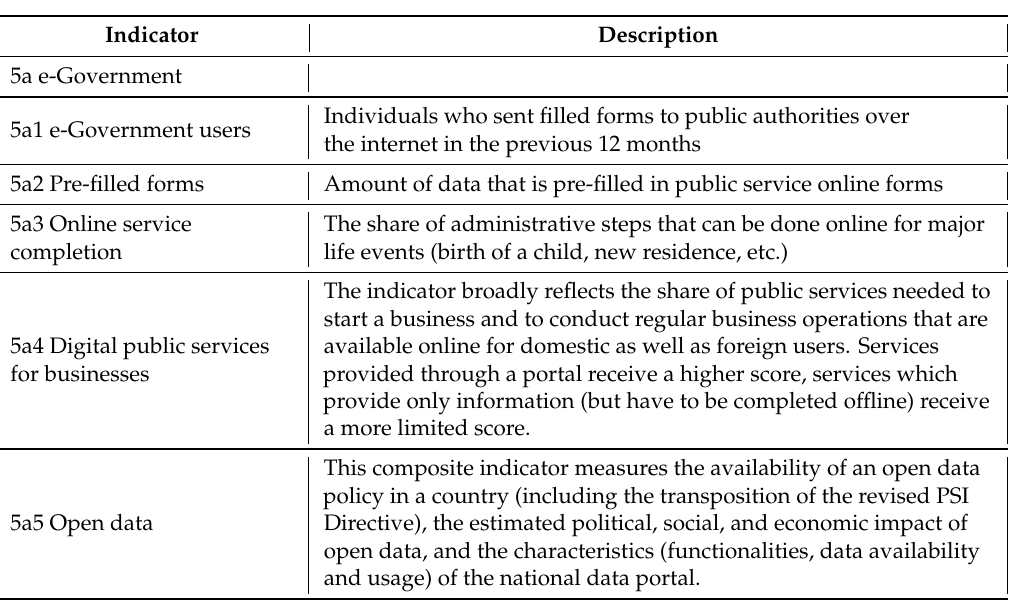
Table 5. A Dimension of Digital Public Services in the DESI